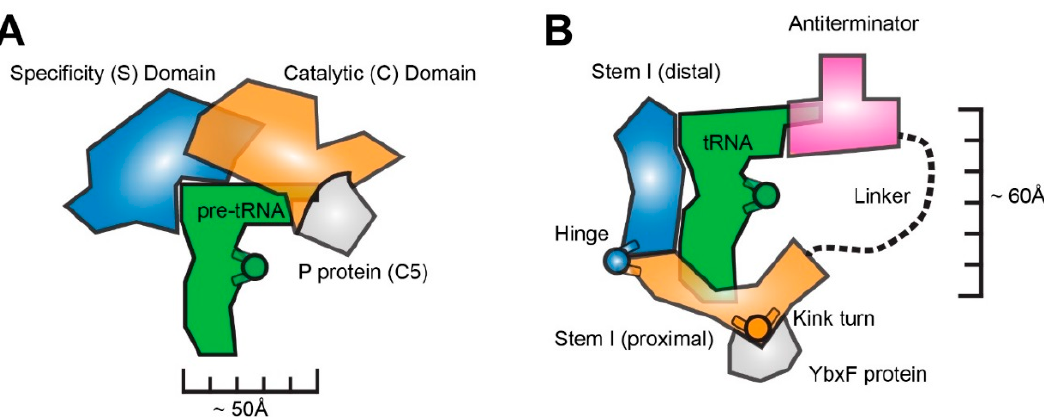
Figure 1. Cartoon representations of the overall domain organization of bacterial RNase P ribozymes ( A ) and T-box riboswitches ( B ). Circles with two projecting arms denote location of molecular “hinges”. Associated proteins that assist the RNA functions are also indicated.